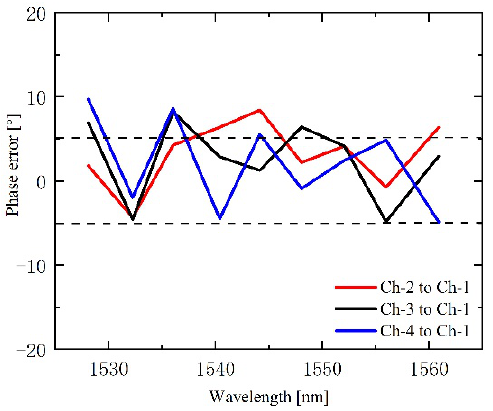
Figure 13. Calculated phase error of the fabricated 90° hybrid.